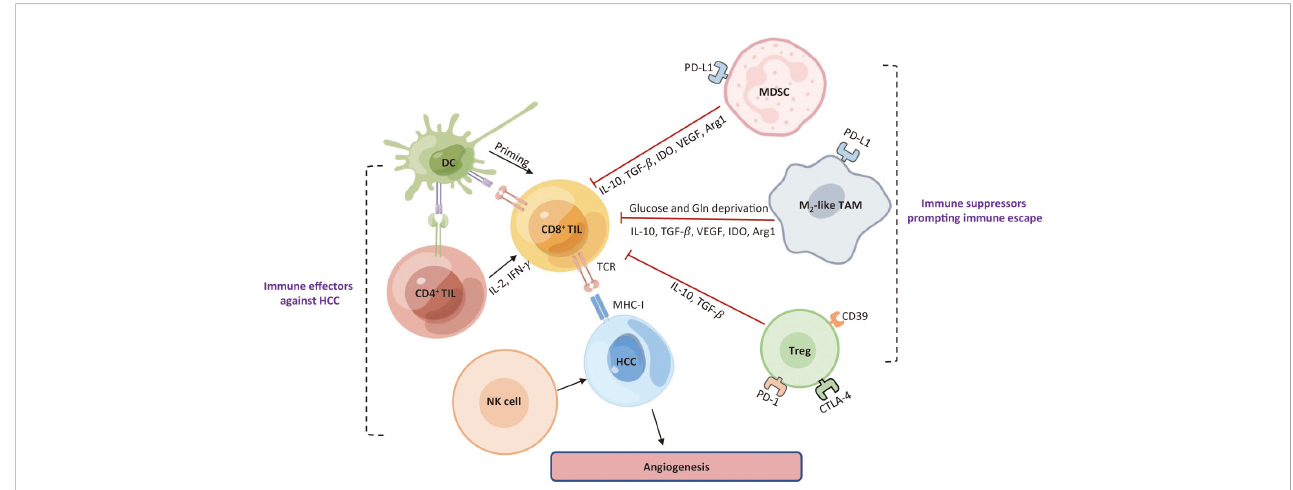
FIGURE 3 Roles of major immune cells in the HCC immune microenvironment. Immune cells existing in HCC can be roughly classi fi ed into one group that prompts an effective anti-tumor response, and the other group that limits immune response against HCC cells and contribute to an immunosuppressive TME. DC, dendritic cell; TIL, tumor-in fi ltrating lymphocytes; NK, natural killer; MDSC, myeloid-derived suppressor cell; Treg, regulatory T; TAM, tumor-associated macrophage; VEGF, vascular endothelial growth factor; TGF- b , transforming growth factor- Β ; IDO, indoleamine 2, 3-dioxygenase; Arg1, arginase 1; Gln, glutamine; TCR, T cell receptor; MHC-I, major histocompatibility complex I; TME, tumor microenvironment; HCC, hepatocellular